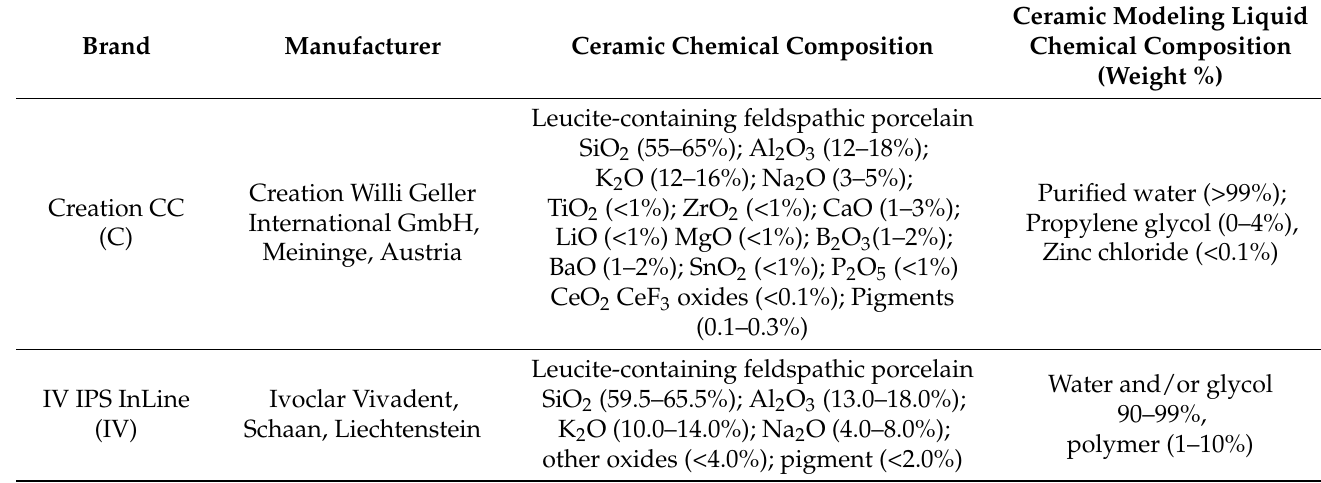
Table 1. Chemical compositions of different ceramics and related modeling liquids, according to manufacturers.